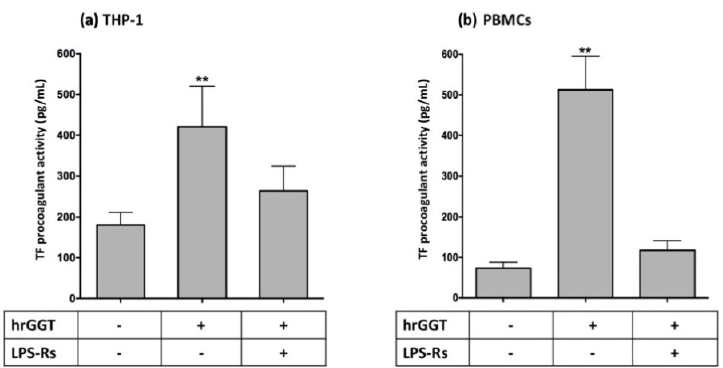
Figure 10. TF procoagulant activities measured in THP-1 ( a ) and PBMCs ( b ). Both cell lines were pre-treated with a specific TLR4 antagonist (i.e., 1 µg/mL LPS-Rs) for 30 min and subsequently stim- ulated with hrGGT (1 µg/mL for 4 h for THP-1 and 0.5 µg/mL for 18 h for PBMCs). Data are pre- sented as mean ± SEM ( n = 4). ** p < 0.001 vs. the basal condition.